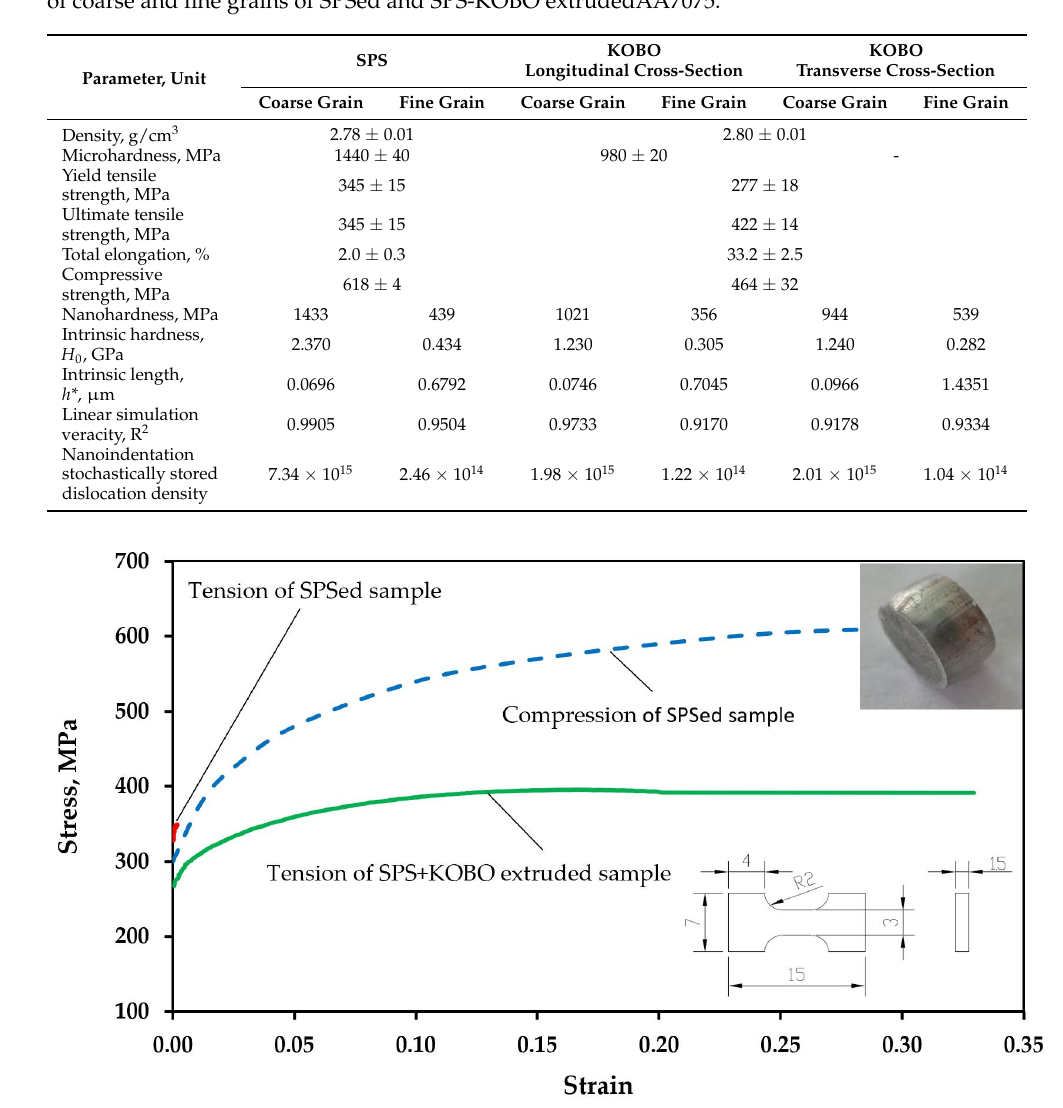
Figure 9. Tension and compression stress–strain curves of SPSed and SPS-KOBO extruded AA7075. Insets: tensile specimen drawing (dimensions in mm), photograph of specimen after compression test.